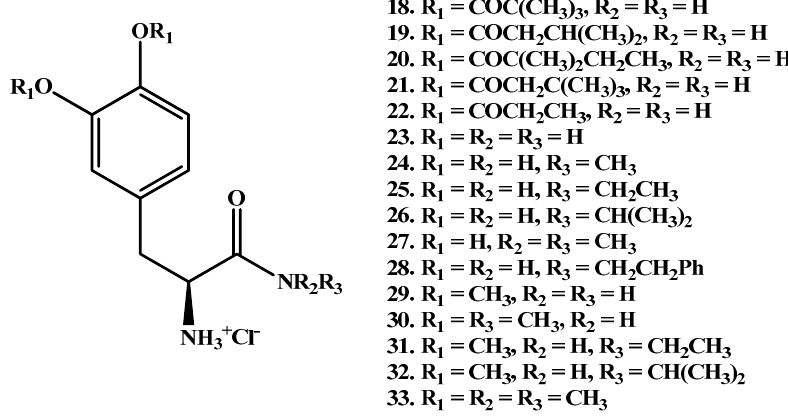
Figure 5. Chemical structures of a synthetic series of amide prodrugs, 18 – 33 .